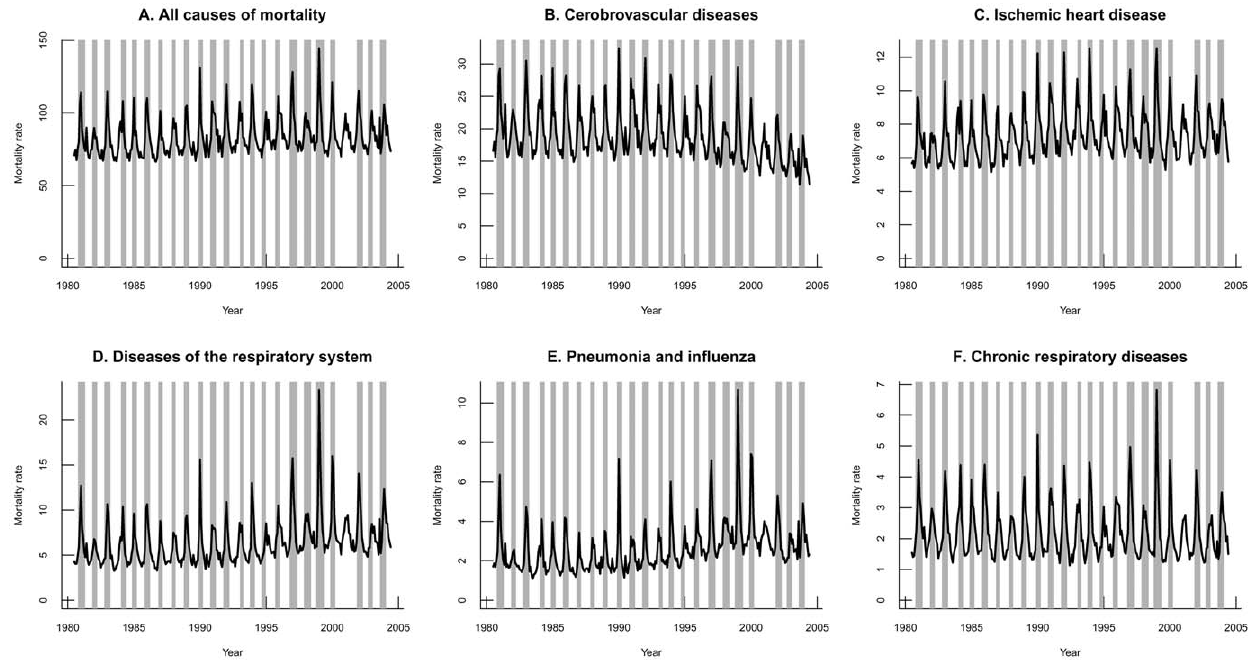
Figure 1. All age mortality rates for all causes, diseases of the respiratory system and pneumonia and influenza from 1980/81 to 2003/2004 in Portugal. Grey highlights represent influenza epidemic periods.